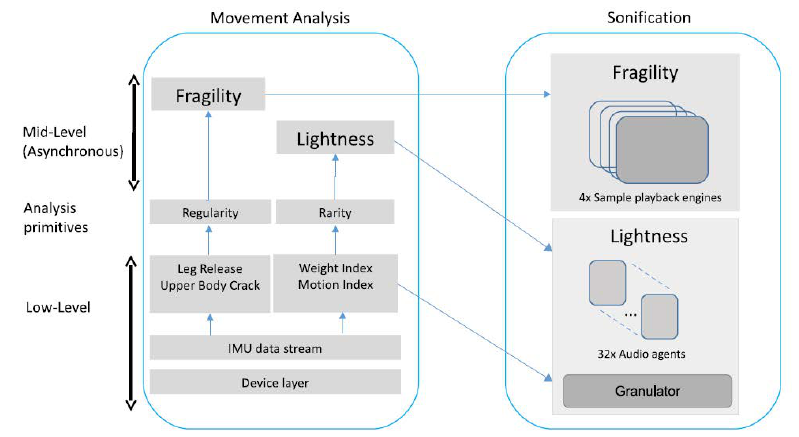
Fig. 1 The framework of a specific action segment rehearsal system in a high-dynamic dance